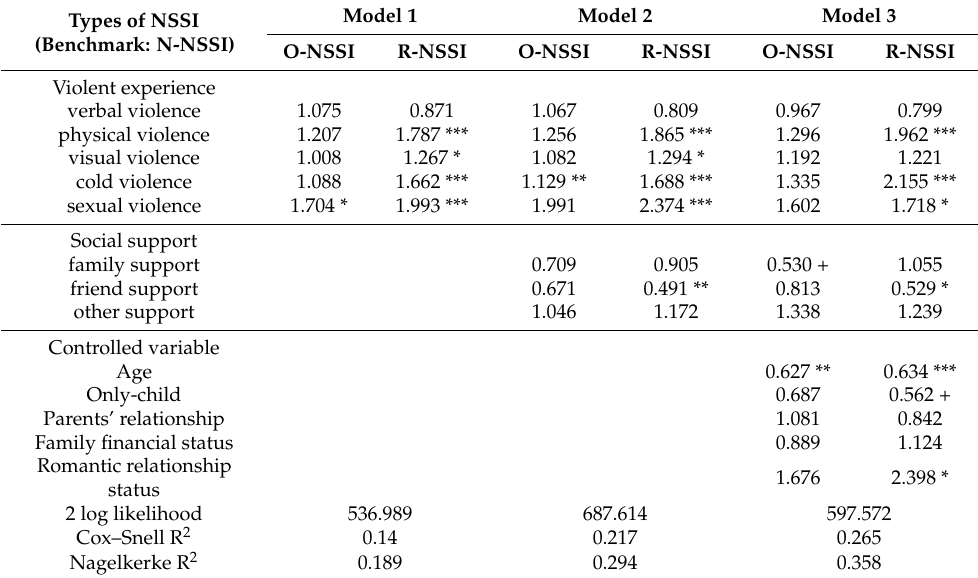
Table 2. Violent experience and social support on NSSI and R-NSSI behaviors of male students. Types of NSSI (Benchmark: